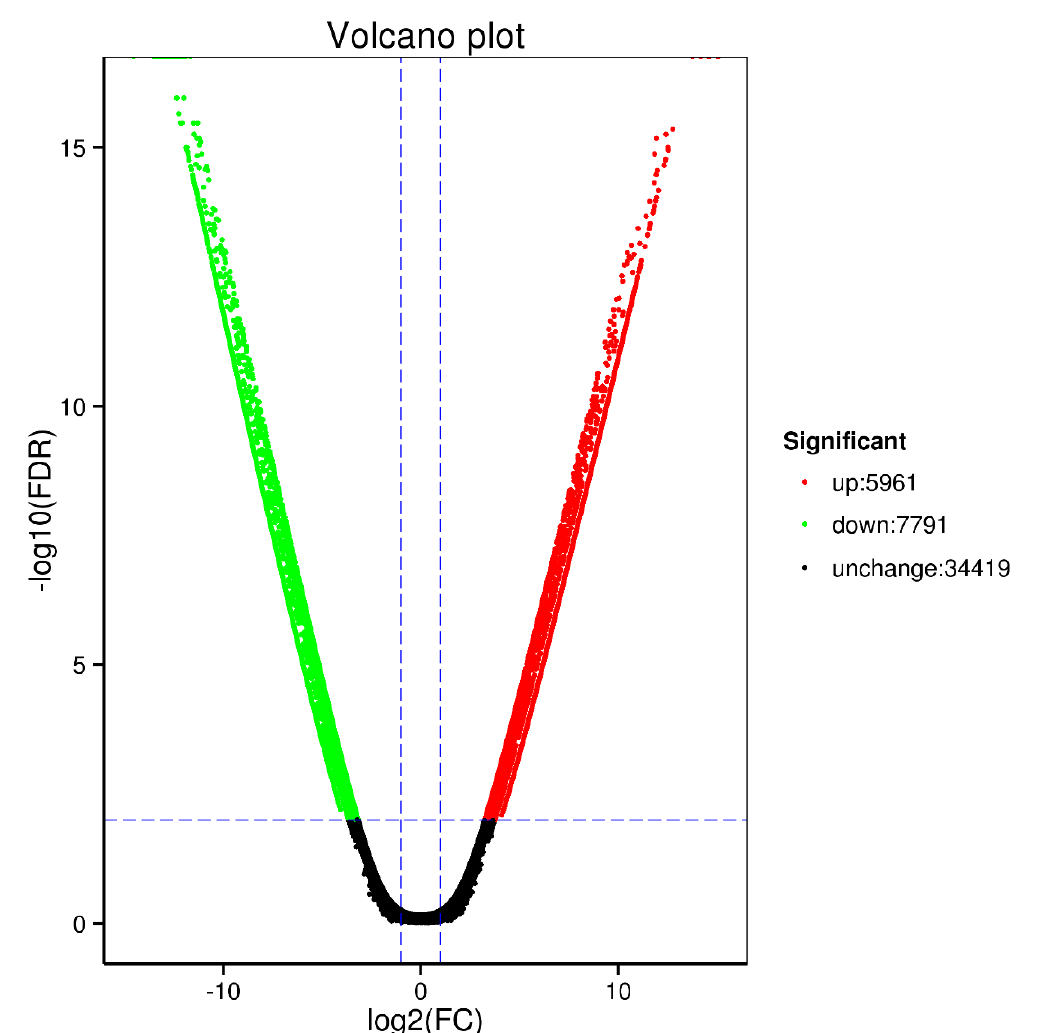
Figure A1. The volcanic map of DEGs between the two individuals numbered S05 and S11. Each point in the volcanic map represents a transcript. The abscissa stands for the logarithm of the multiple change of the difference in expression of a given transcript between the two samples. The ordinate represents the negative log of statistically significant changes in transcript expression. The larger the ordinate value is, the more significant the differential expression is, and the more reliable the screened differential expression transcript is. The green dots represent down-regulated DEGs, the red dots represent up-regulated DEGs, and the black dots represent non-differentially expressed transcripts.